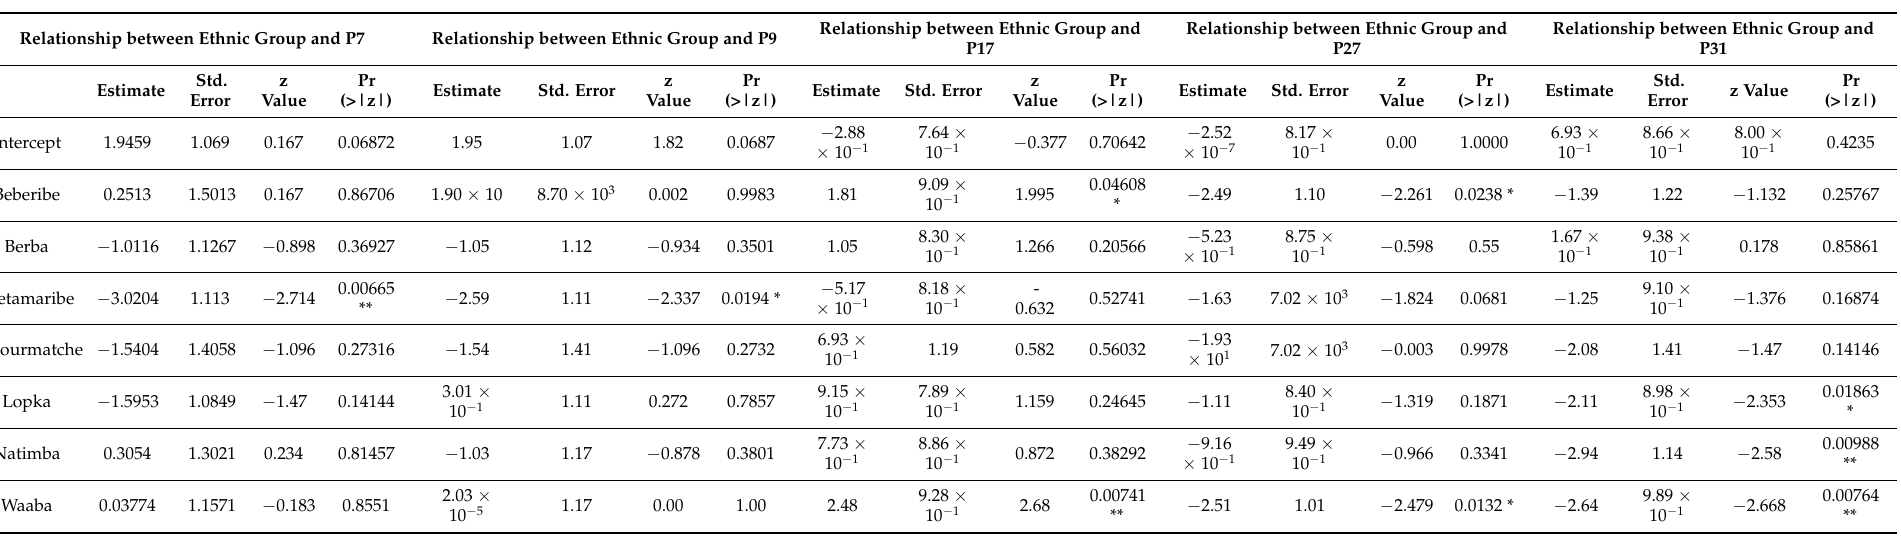
Table A2. Results of the generalized mixed effect model showing the relationships between farmers ethnic groups and the adoption of CSAP for significant factors.